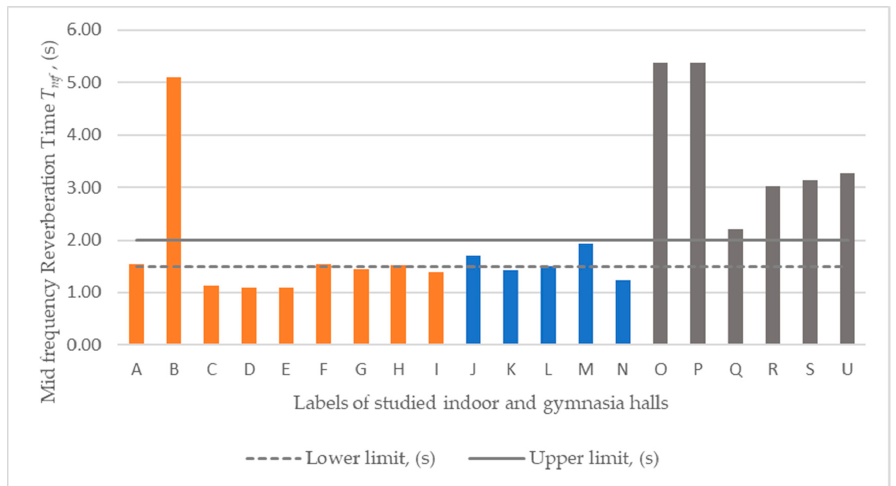
Figure 6. Measured mid-frequency reverberation time, T mf (s), for the studied IS & G halls. Orange bars represent Category I, blue bars represent Category II, and grey bars represent Category III. According to BB [1], the lower limit of recommended T mf is for IS & G halls of Category I and upper limit of recommended T mf is for Category III.